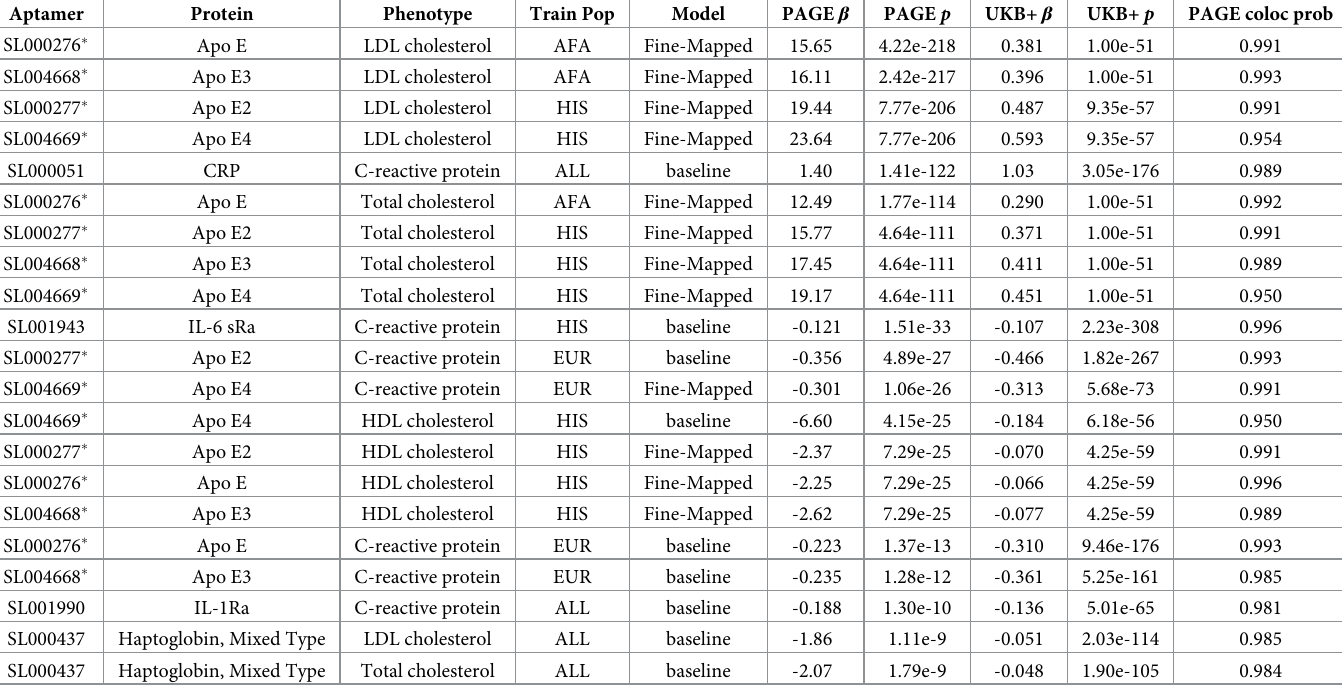
Table 2. Significant protein-trait associations found in PAGE, colocalized, and replicated in UKB+. Each protein-phenotype pair may be present across multiple popu- lations for different model building strategies. For each distinct protein-phenotype pair we present only the model association with the lowest p value in PAGE. All signifi- cant associations are listed in S7